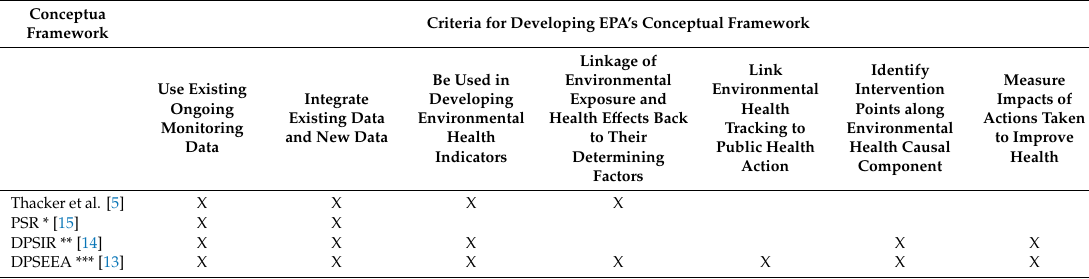
Table 2. EPA’s criteria for selecting a conceptual